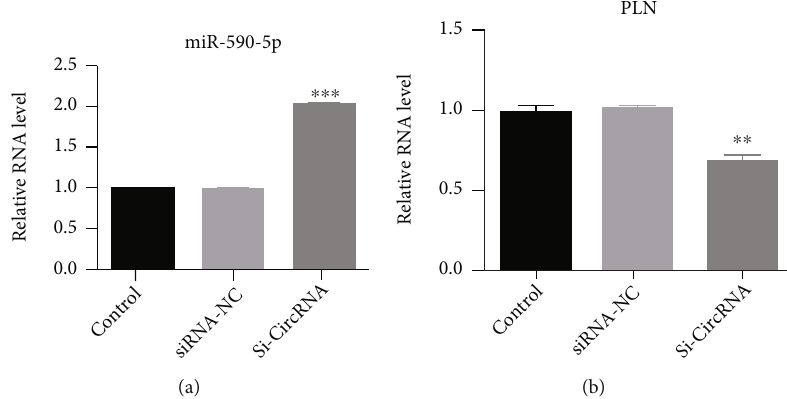
Figure 9: Validation of hub Genes by qRT-PCR. (a) The level of miR-590-5p expression. (b) The level of PLN expression. Black represents control group. Light grey represents transfection hsa-circ-0002917 siRNA negative control of gastrointestinal stromal tumor cells. Dark grey represents transfection hsa-circ-0002917 siRNA gastrointestinal stromal tumor cells. All data were expressed as the mean ± SD . ∗ P < 0 : 05